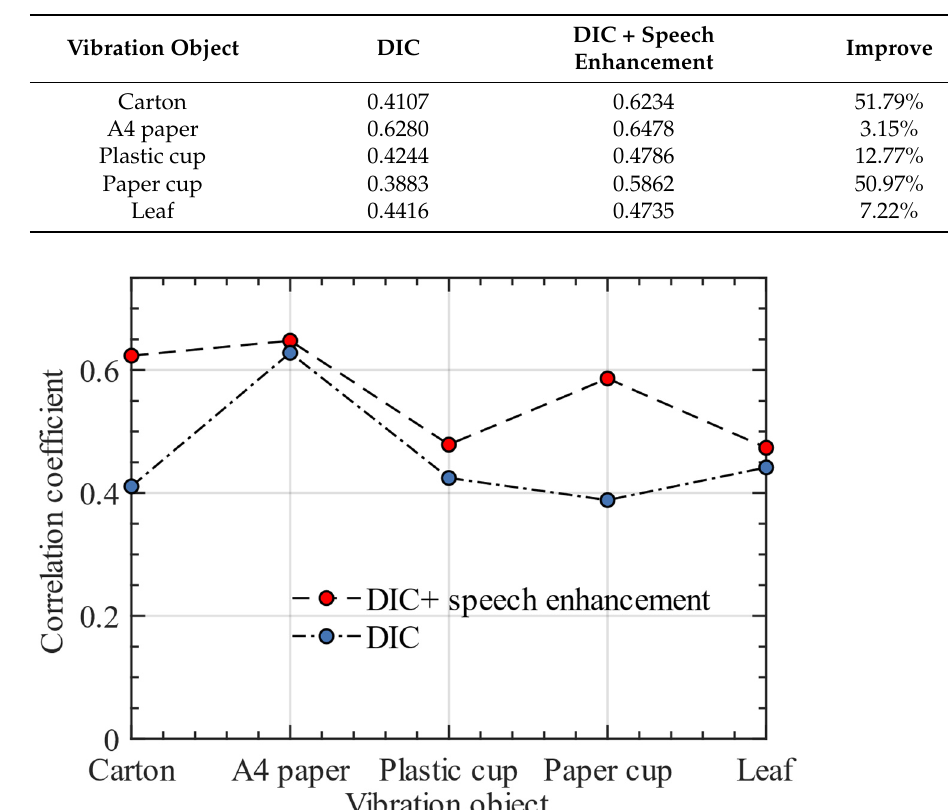
Table 9. Comparison of the speech reconstruction accuracies of five vibration object datasets.